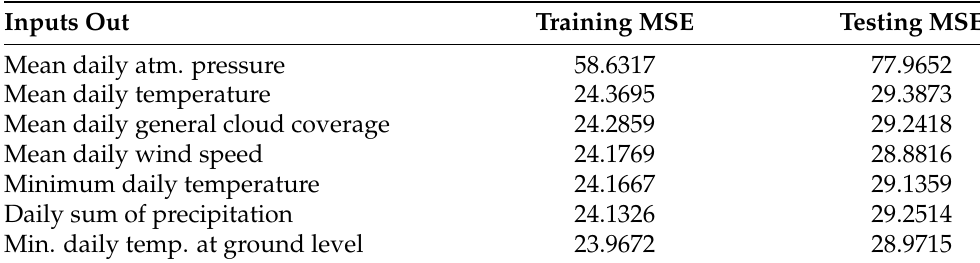
Table A13. The results of the sensitivity analysis for the prediction of the mean daily atmospheric pressure.